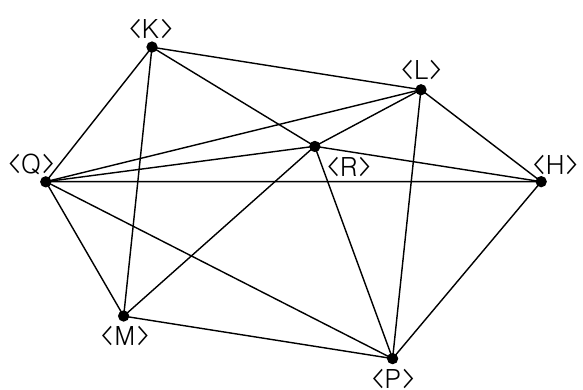
Figure 5 . SO(2 N ) = U( N ), N = 4 m + 1. Vertices, line segments and triangular faces correspond to vacua, walls and three-pronged